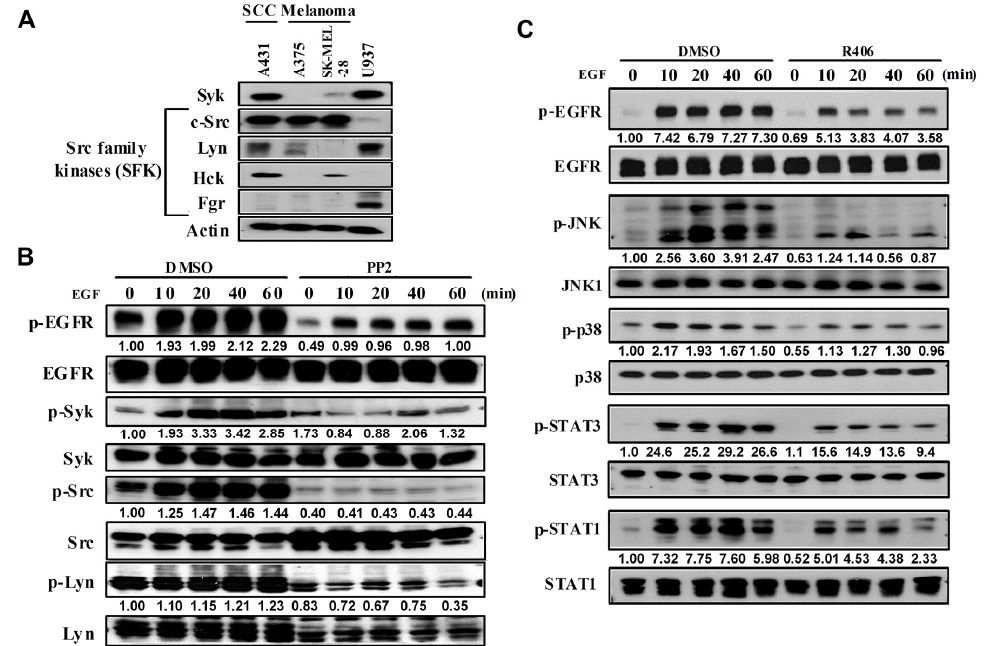
Figure 1. EGF can induce Syk activation through SFK signalling in A431 cells. ( A ) Western blot analysis of Syk and SFK expression in various cancer cell lines. ( B ) Phosphorylation of EGFR, Syk, Src, and Lyn after EGF (100 ng/mL) treatment with or without PP2 (10 μ M) for 0, 10, 20, 40, and 60 min in A431 cells. ( C ) Phosphorylation of EGFR downstream signalling molecules after EGF (100 ng/mL) treatment with or without R406 (1 μ M) for 0, 10, 20, 40, and 60 min in A431 cells. Data are presented from three independent experiments.